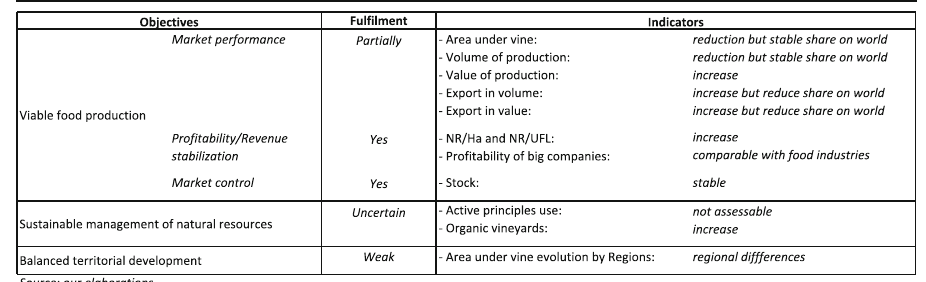
Table 7 Wine sectoral performance vs. policy